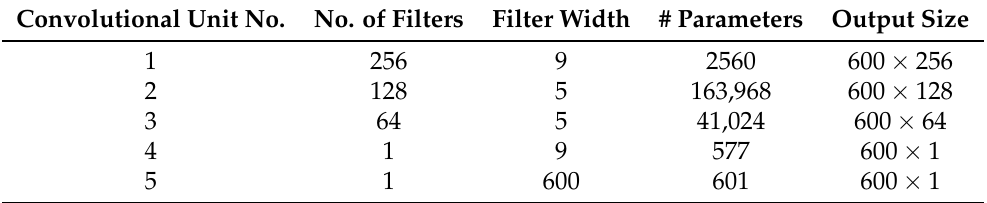
Figure 1. An example of the simulated data used to train the proposed algorithm. The original spectrum, X ref , that was produced using Equation (6) and the spectrum after simulated Poisson noise were introduced where the SNR for each resulting spectrum is ( a ) 120, ( b ) 60 and ( c ) 25, respectively. The peak formations that were selected for training the algorithm for the local MSE are outlined by a black box in reach case. Table 1. Network